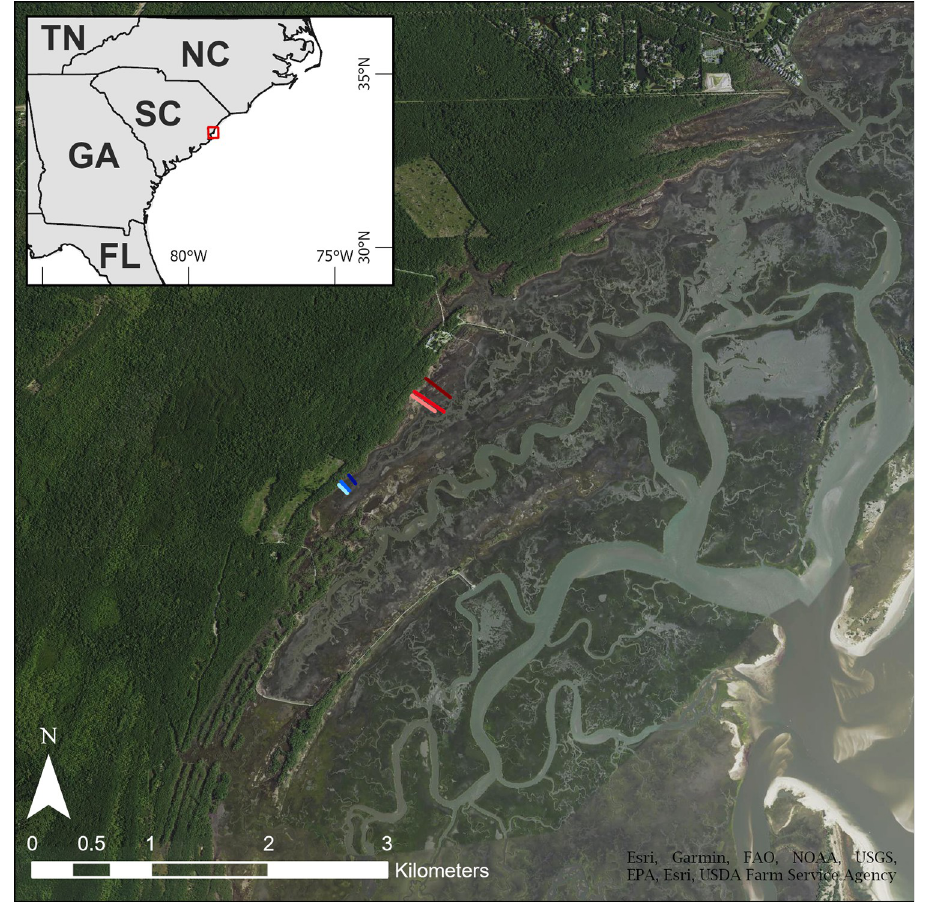
Fig 1. Map of study site. Aerial view of North Inlet Estuary (South Carolina, USA), where the North Inlet–Winyah Bay National Estuarine Research Reserve (NI-WB NERR) has established permanent vegetation monitoring program along the marsh platform of Crabhaul Creek. 51-1m 2 permanent monitoring plots comprise 6 transects across two distinct segments of the marsh platform. The red lines represent transects at Segment A, while the blue lines represent transects at Segment B. Content is the intellectual property of Esri and is used herein with permission. Copyright © 2022 Esri and its licensors. All rights